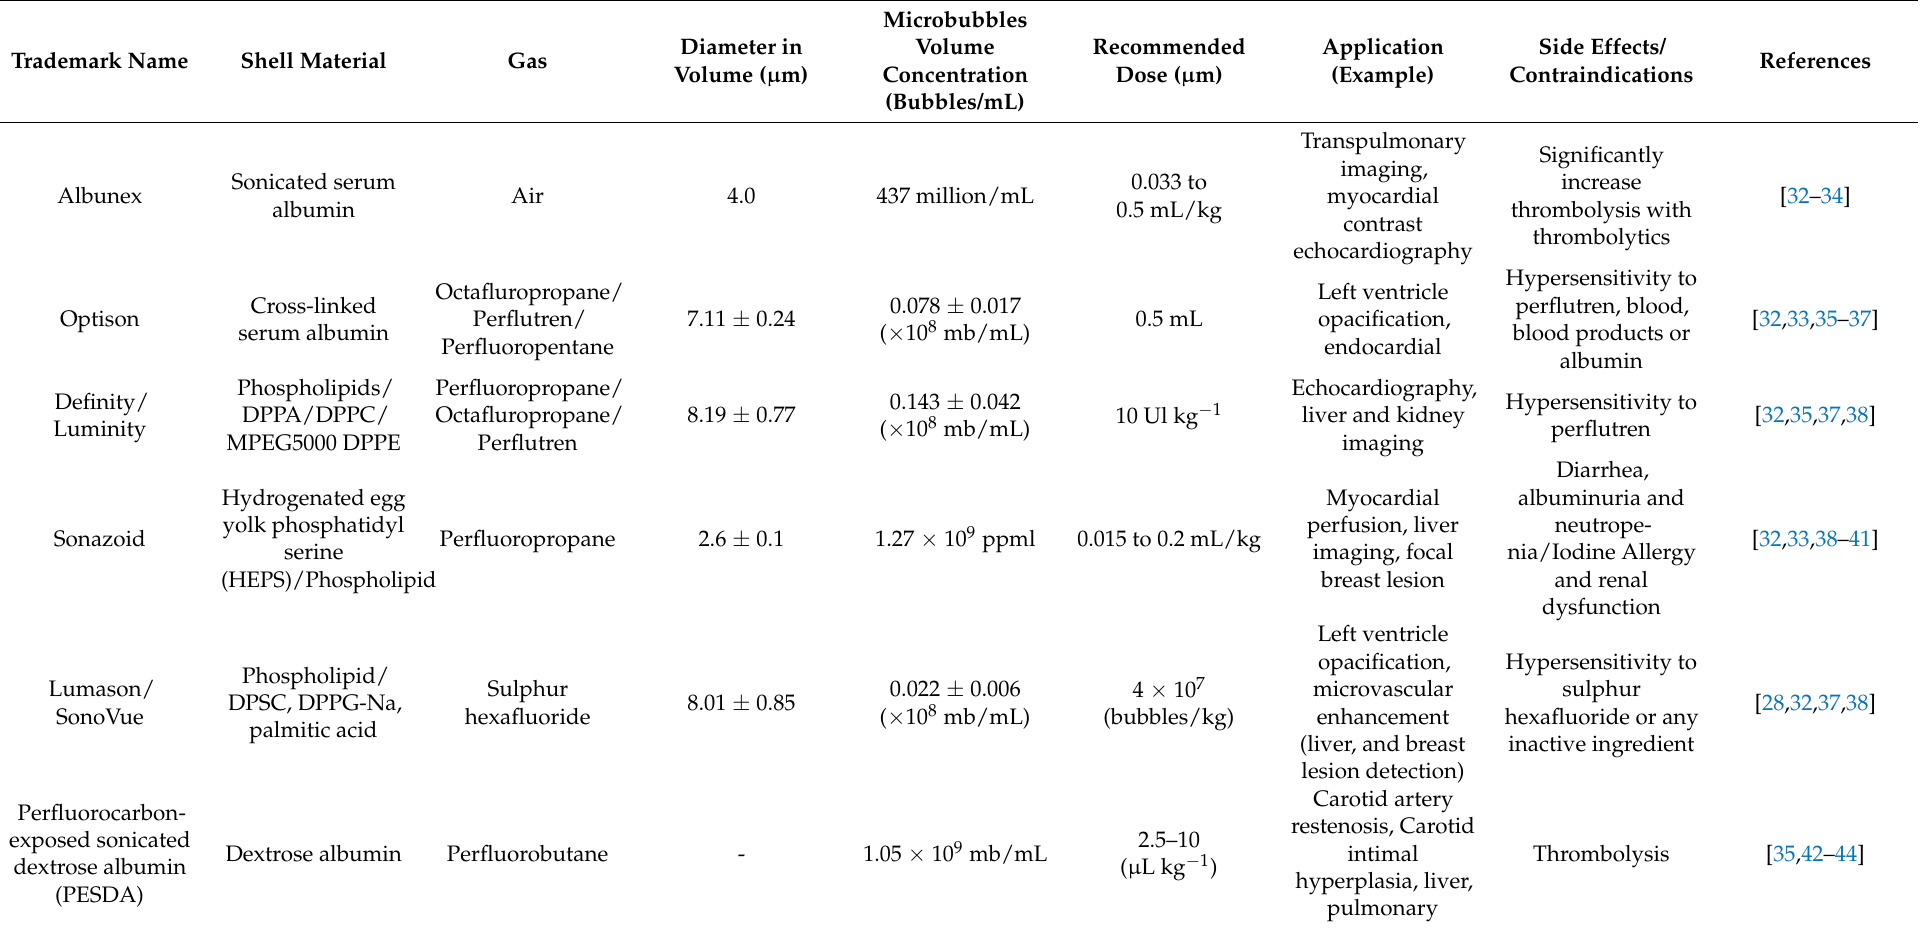
Table 1. Common US microbubble contrast